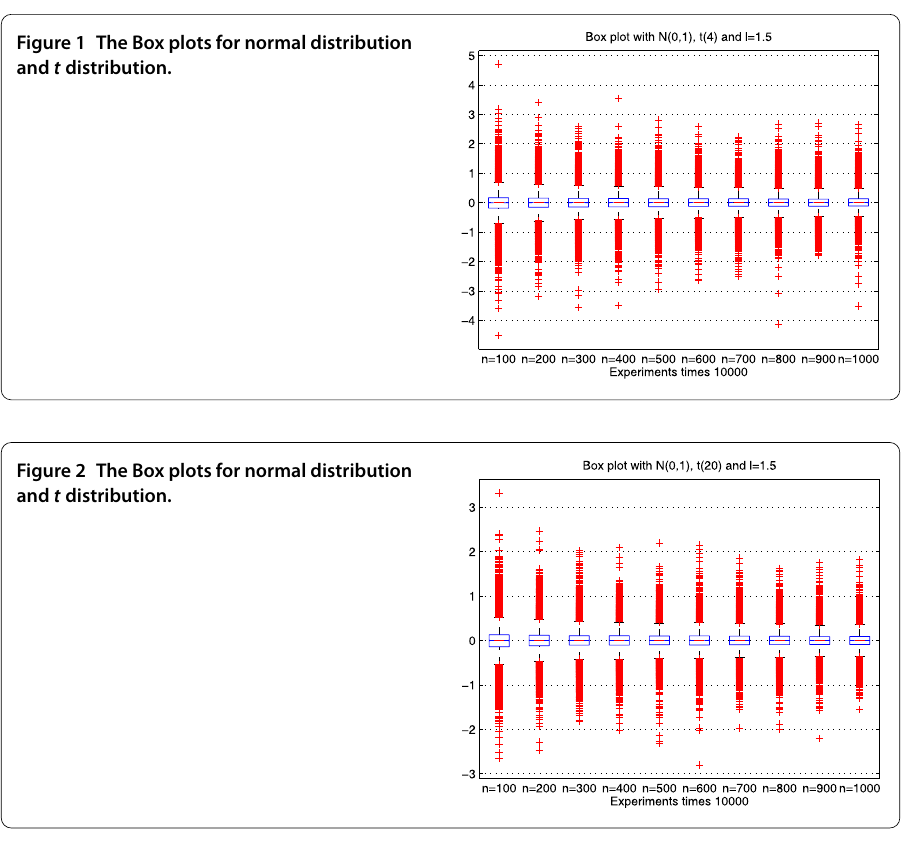
Figure 1 The Box plots for normal distribution and t distribution.